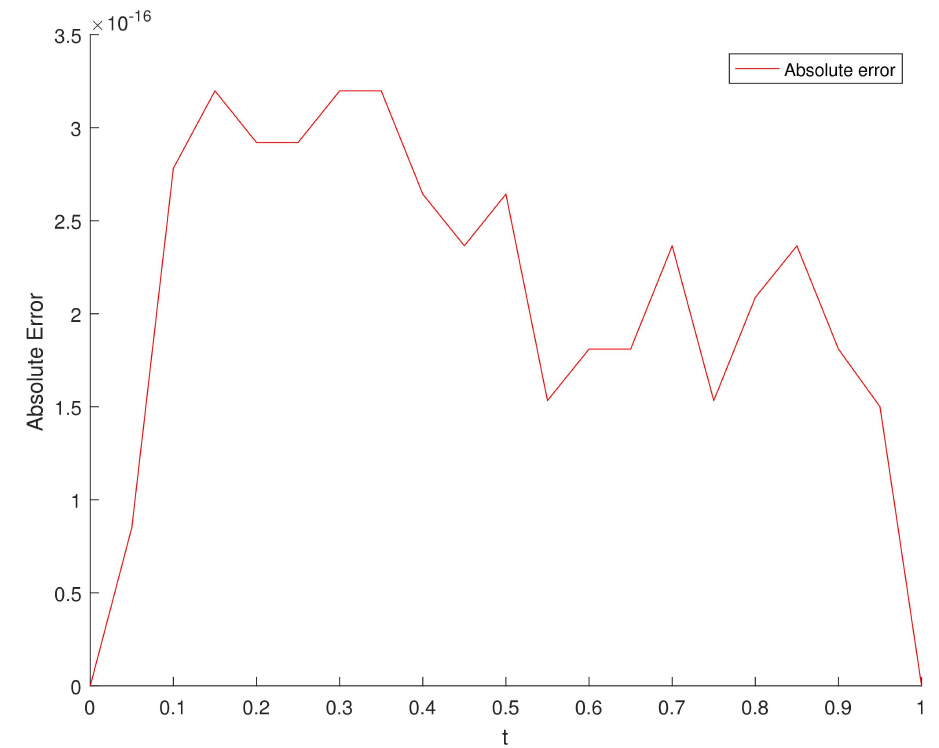
Figure 7. The absolute error of the approximate solution for Example 2 with τ = 0.001